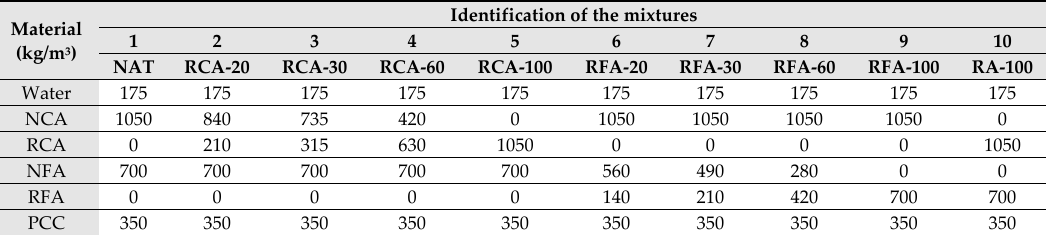
Table 3. Proportion of the test mixtures. PCC: Portland composite cement.